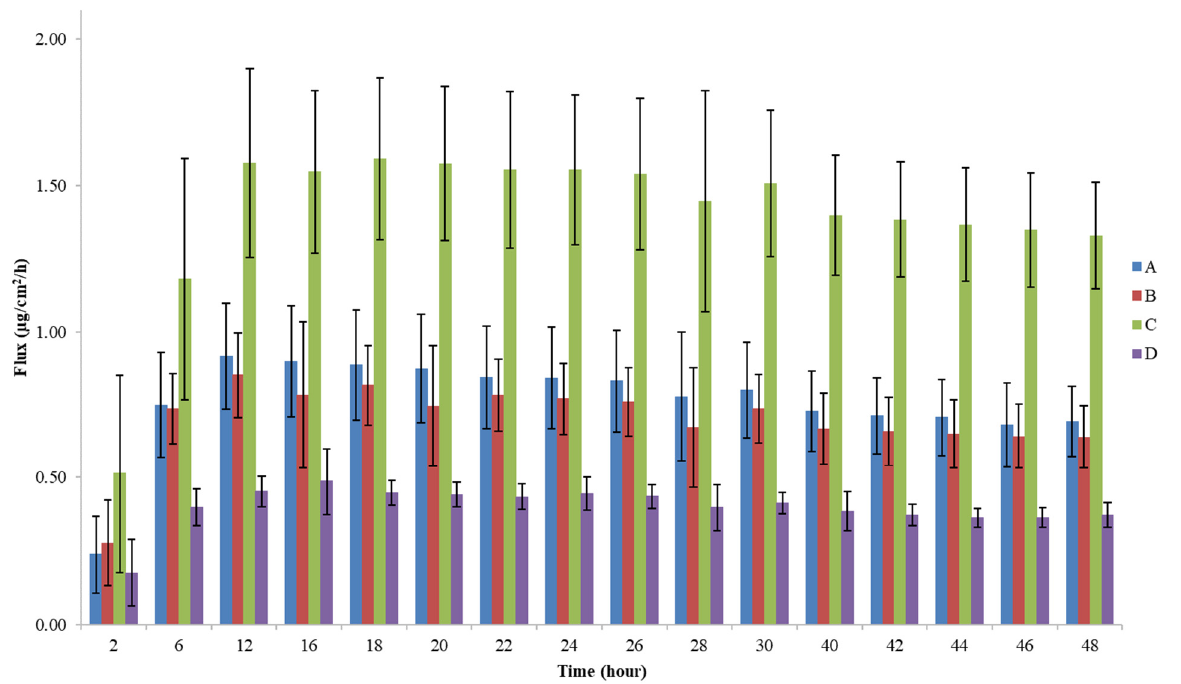
Figure 3. Flux ( µ g/cm 2 /h) obtained at each timepoint throughout the 48 h assay ( n = 12) (A—clotrimazole 10 mg/g cream; B—Canesten Antifungal Cream 10 mg/g cream; C—clotrimazole 20 mg/g cream; D—clotrimazole 5 mg/g cream).